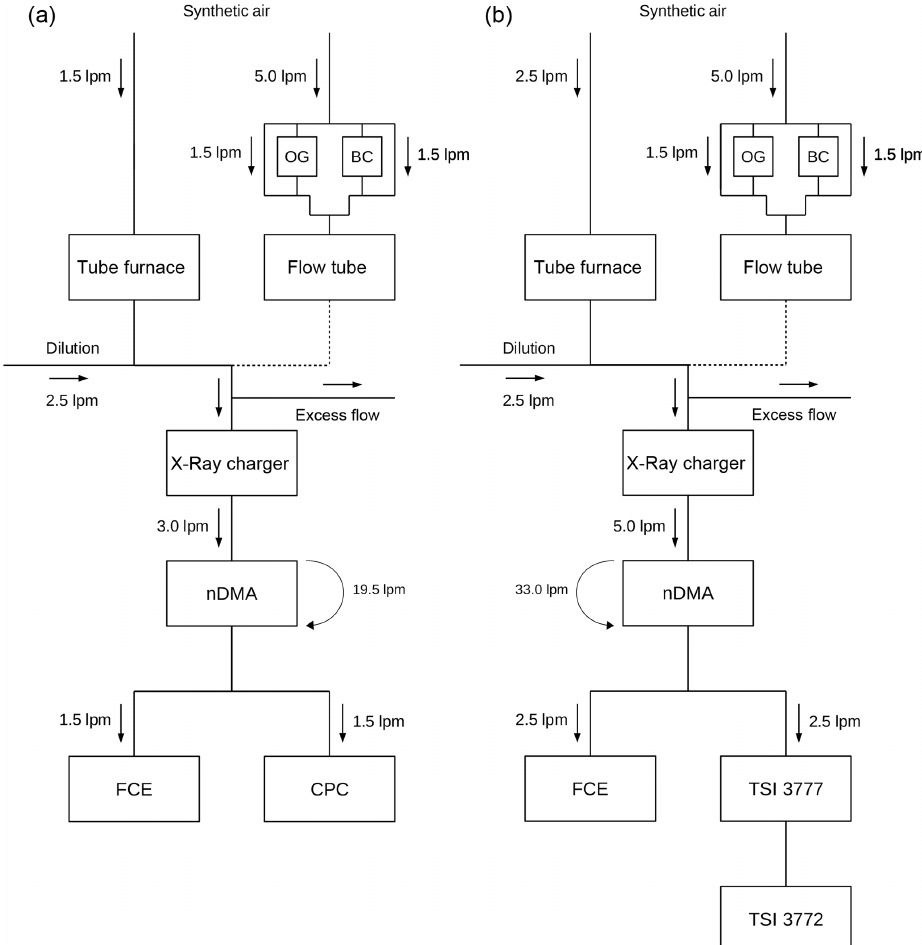
Figure 1. Schematic of the experimental setup: the figure shows a schematic of the experimental setup that was used to measure the detection efficiency of the ultrafine particle counters. A Faraday cup electrometer was used as a reference. C 15 H 24 O x seeds were generated using BCY (BC), an ozone generator (OG) and a flow tube. The curved arrows mark the sheath air cycle. Panel (a) shows the setup for the measurements involving just CPCs. Due to the higher aerosol inlet flow rate of the TSI 3777 the setup was modified (b)